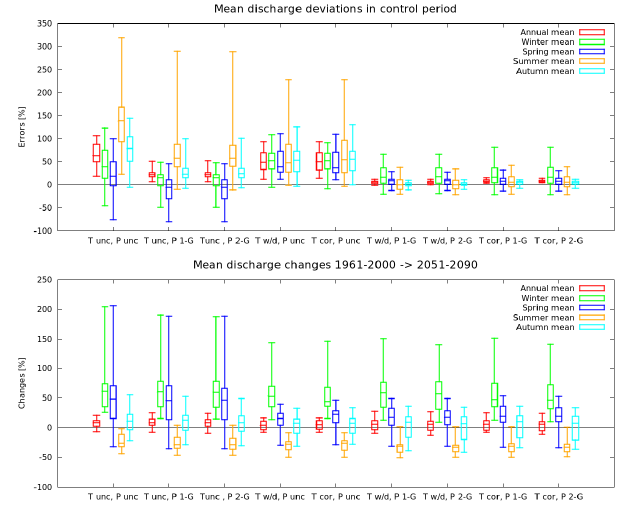
Figure 13. The minimum, maximum, 1st and 3rd quartile and me- dian deviations of the simulated mean discharges with RCM data compared to control simulations (above) and climate change im- pacts (below) in four test sites using all five scenarios without cor- rections (unc), only with temperature correction ( T w–d is wet–dry separation and T cor is without separation) or precipitation correc- tions (1-G is single gamma and 2-G is double gamma) and with both temperature and precipitation